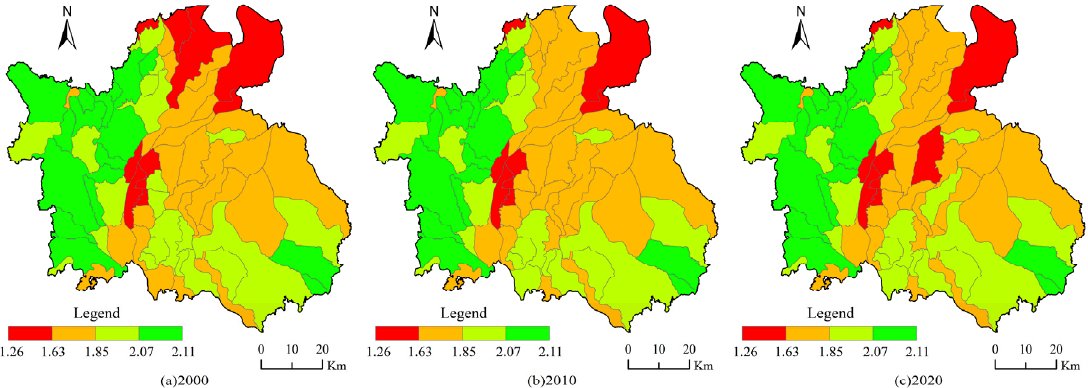
Figure 6. Spatial evolution of function resilience of Nanchang City based on water network group.